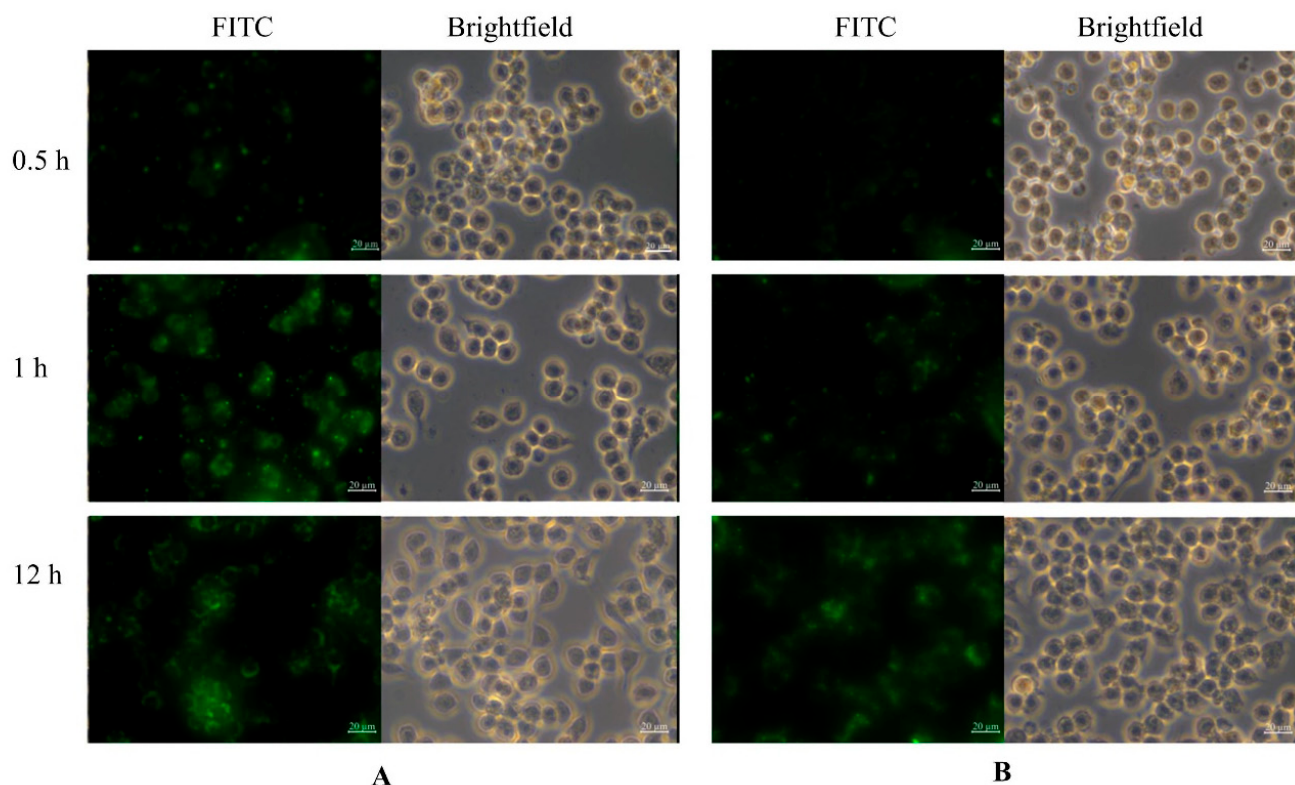
6 of 13 Figure 1. Synthesis of mSiO 2 and MTX-mSiO 2 @PDA. ( A ) TEM images of mSiO 2 ; ( B ) DLS size distribution of mSiO 2 ; ( C )